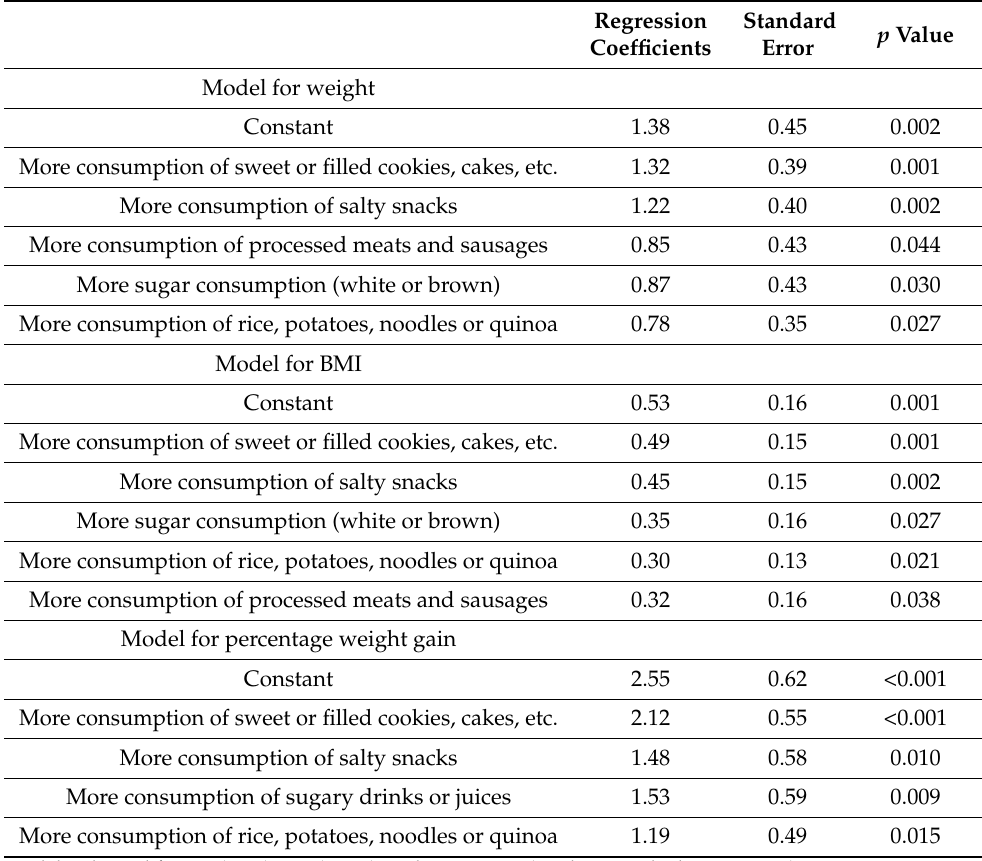
Regression Standard p Value Coefficients Error